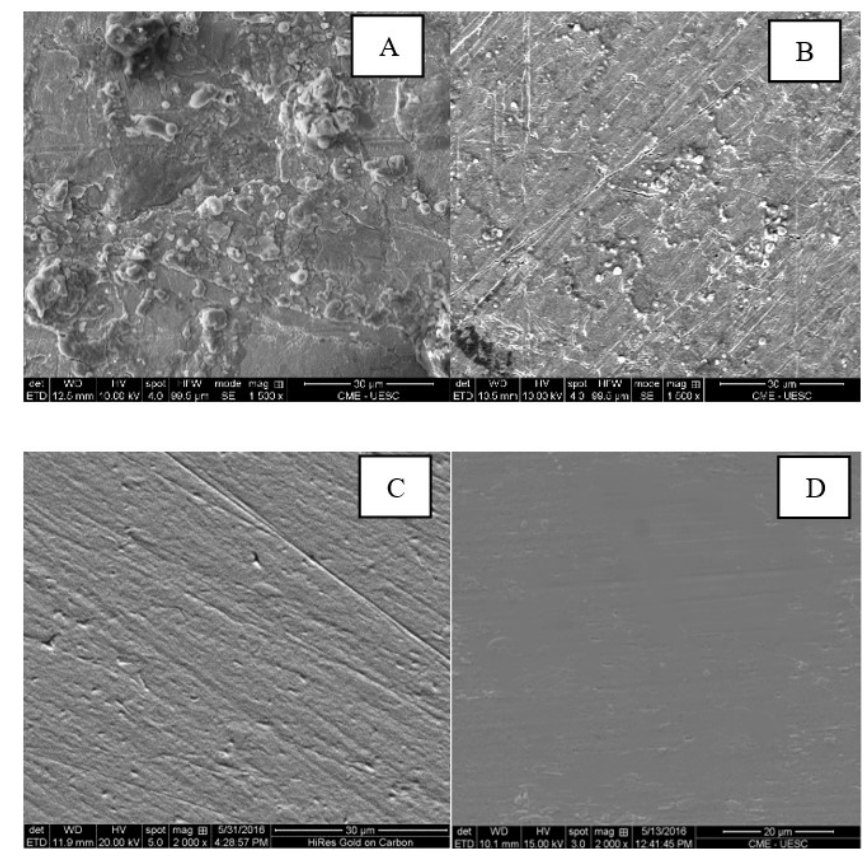
Figure 10. SEM images of ASTM 1020 carbon steel after 120 min of immersion in 0.5 mol.L -1 HCl solution in the absence (a) and the presence of CBP (b), PKCP (c), and the synergism of CBP and PKCP